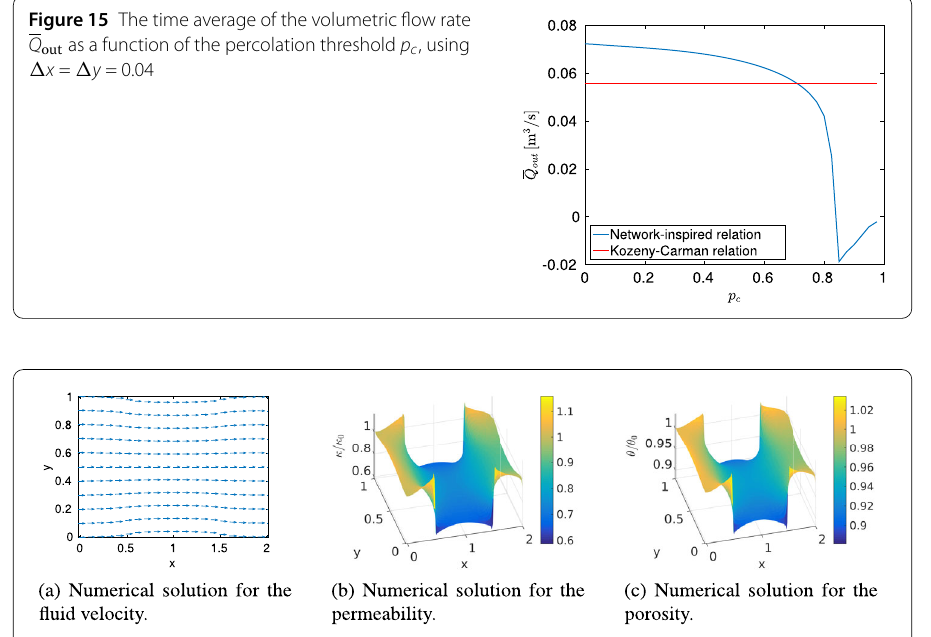
Figure 16 Numerical solutions for the fluid velocity, the permeability and the porosity, at time t = 300, obtained using the Kozeny–Carman